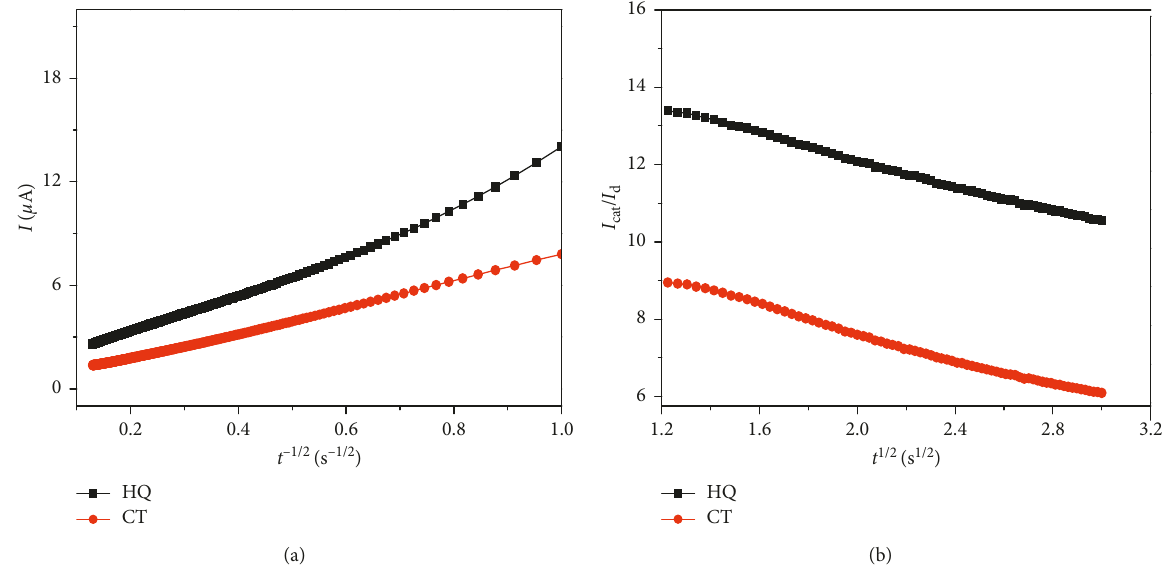
Figure 6: (a) Dependency of transient current on t − 1/2 . (b) Chronoamperometric measurements of I